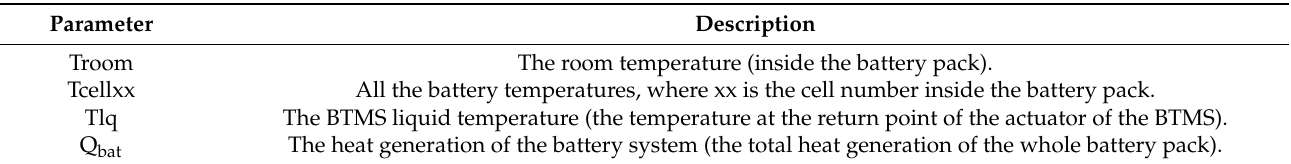
Table 3. Cherry-picked inputs of the controller. Parameter Description Troom The room temperature (inside the battery